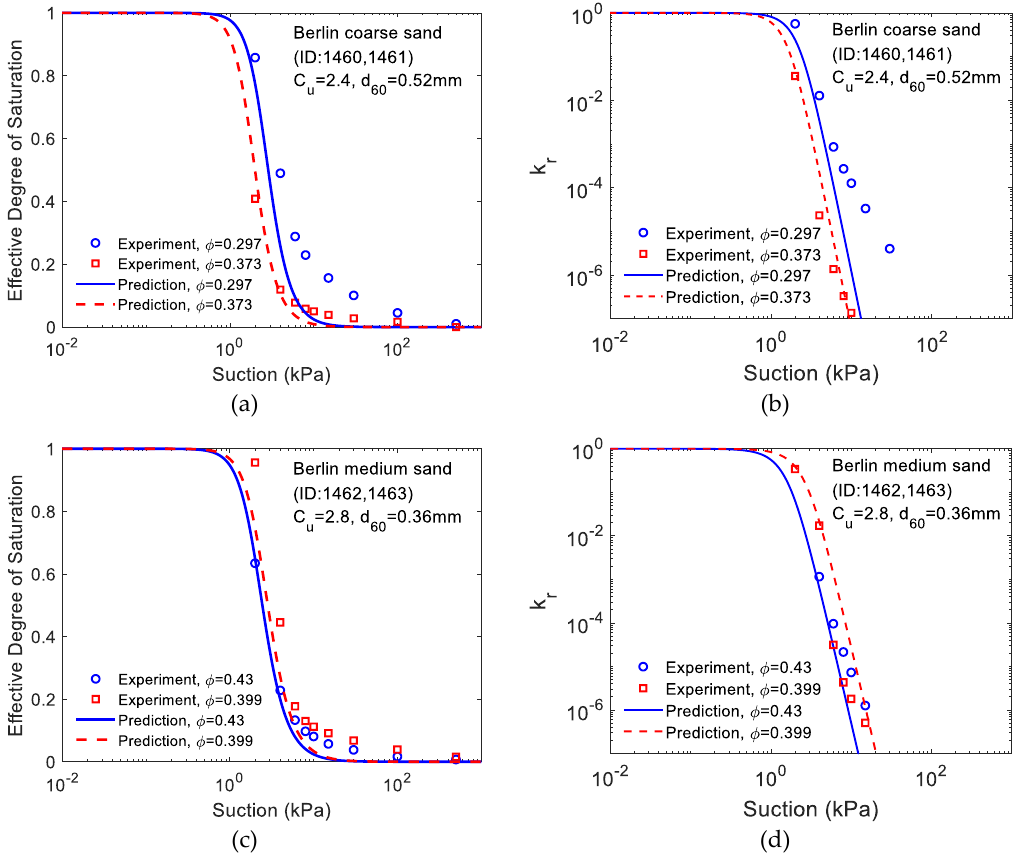
Figure 7. Prediction performance of coarse and medium Berlin sands. ( a ) water retention curve of Berlin coarse sand; ( b ) relative permeability of Berlin coarse sand; ( c ) water retention curve of Berlin medium sand; ( d ) relative permeability of Berlin medium sand. Water 2019 , 11 , x FOR PEER REVIEW